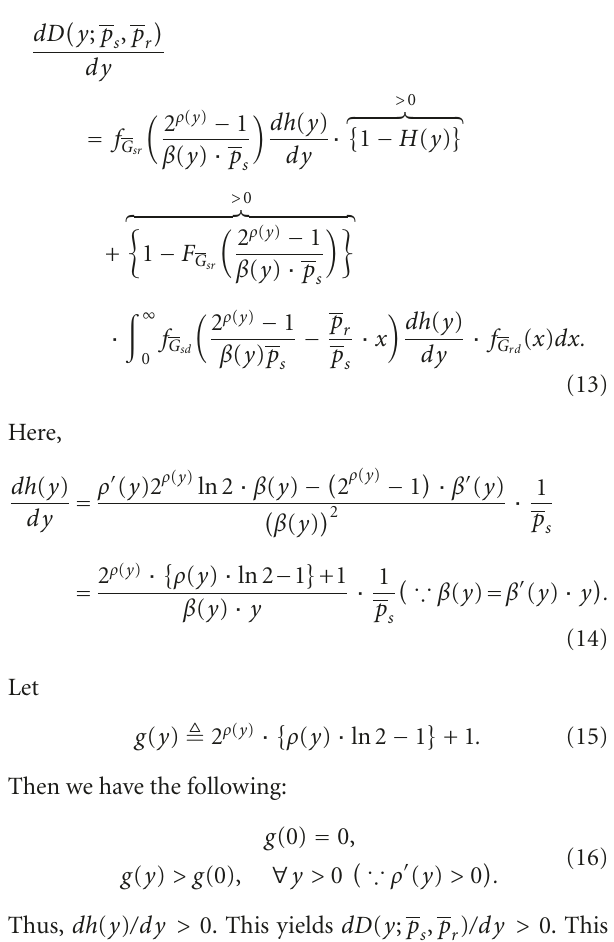
Table 1: Parameters used in experiments.